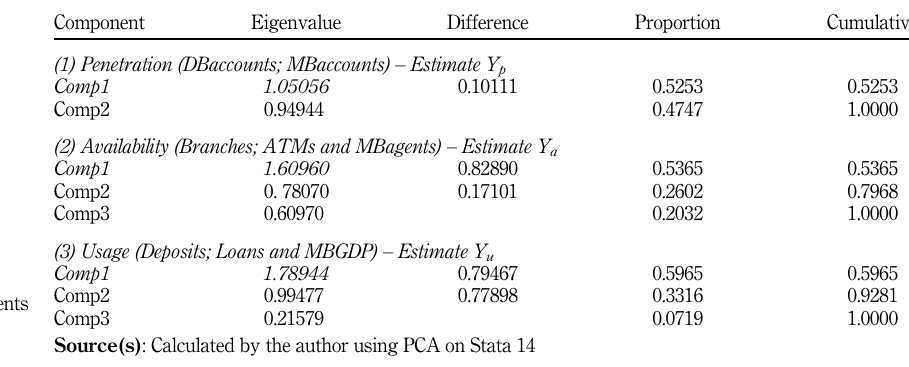
estimates for sub-